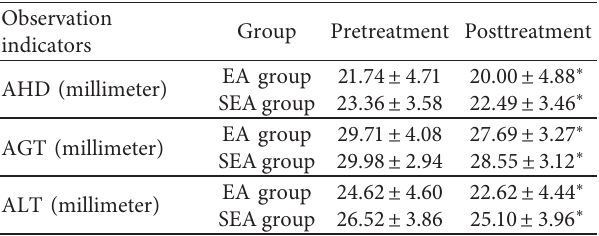
∗ indicates a significant difference as compared with before treatment by using paired t -test, p < 0 . 05. Data are expressed as mean ± standard devi- ation